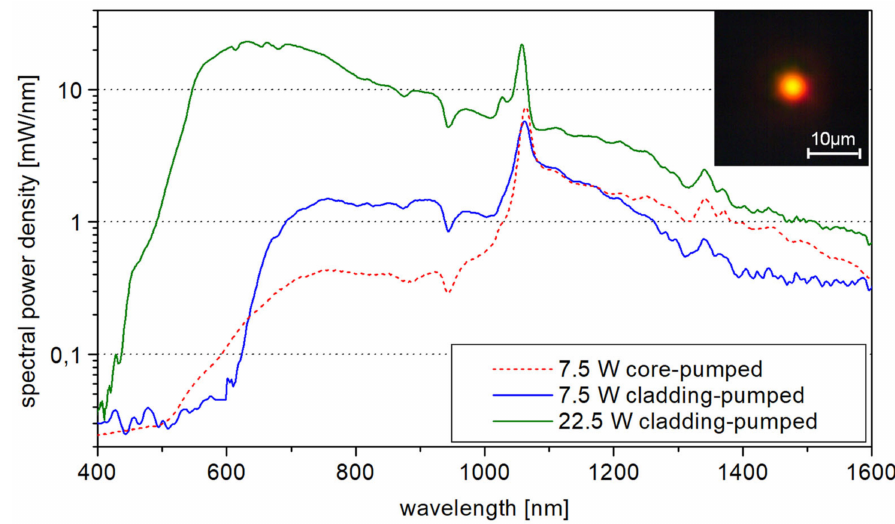
Figure 5. Output spectral power density from 5 m of ESF for the core-pumped SC (red solid curve) and cladding-pumped SC (blue dashed curve) when pumped with 7.5 W. Highest achievable SC output in the cladding modes with 22.5 W pump (green). Core-pumped spectrally integrated profile (inset). The pump was held at a constant 60 kHz repetition rate.